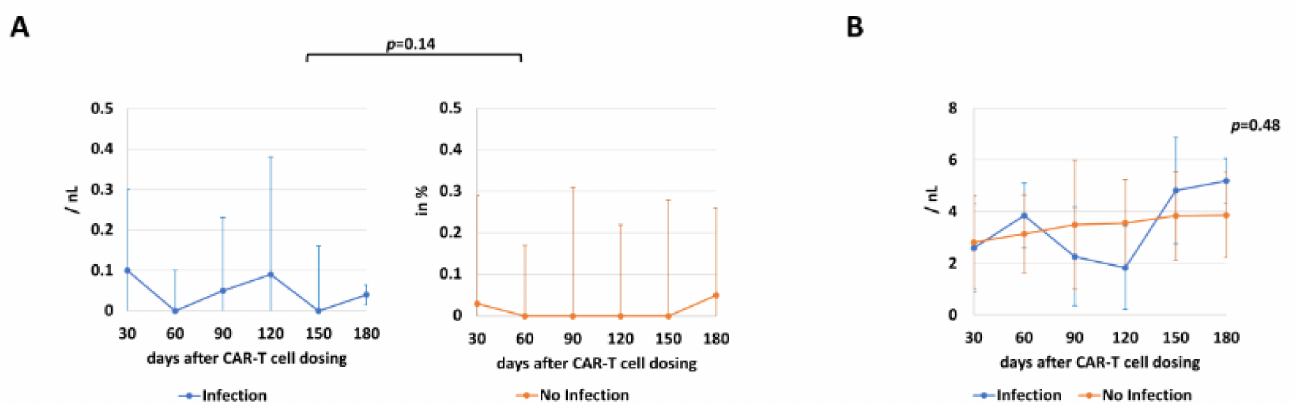
Figure 5. Immune status by measurement of B cell and WBC counts (median and CI). For assessment and comparison of immune status, B cell ( A ) and WBC ( B ) counts (per nanoliter; nL) of patients with and without infection after inpatient stay are shown at different timepoints ranging from day 30 to 180.